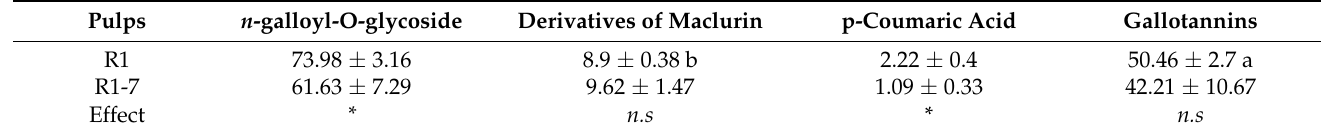
Table 6. Quantification of phenolic compounds in the pulp of ripe (“R”) cv. ‘Cogshall’ mango from H1 harvest depending on storage temperatures. n.s., and *, mean that the effect of storage temperature treatment is non-significant, and significant at p < 0.05, respectively, for H1 harvest